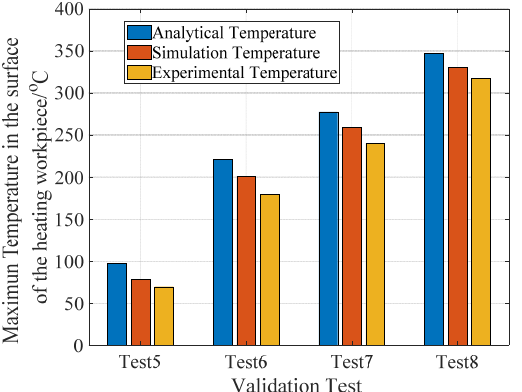
Figure 16. Maximum temperature validation in the surface of the workpiece ( v = 8 mm/s).